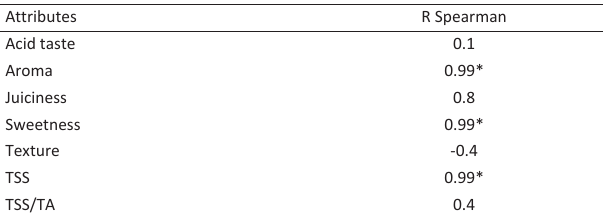
Table 5 - Coefficients of correlation between scores of global appreciation and some sensory and physicochemical traits of peach fruits Attributes R Spearman Acid taste 0.1 Aroma